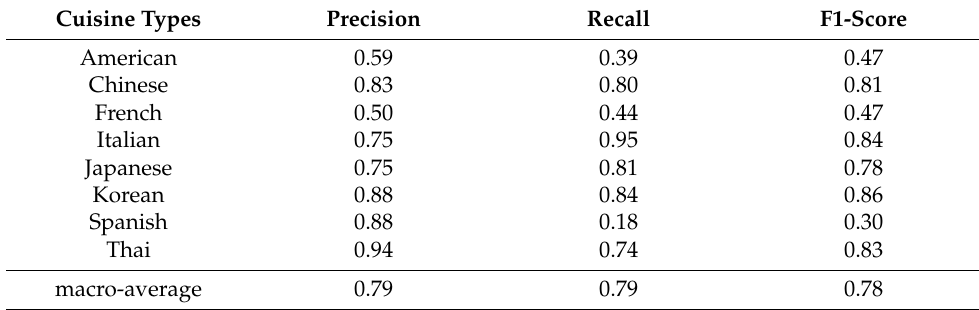
Figure 7. Confusion matrix of the Decision Tree classifier. Table 7. Performance of random forest classifier.